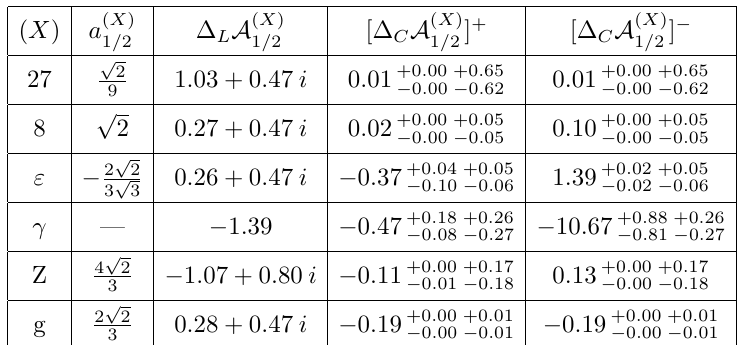
Table 4 . NLO loop and local counterterm amplitudes A amplitudes are associated with the variations of the short-distance scale (cid:22) SD and the chiral scale (cid:23) (cid:31) , respectively.